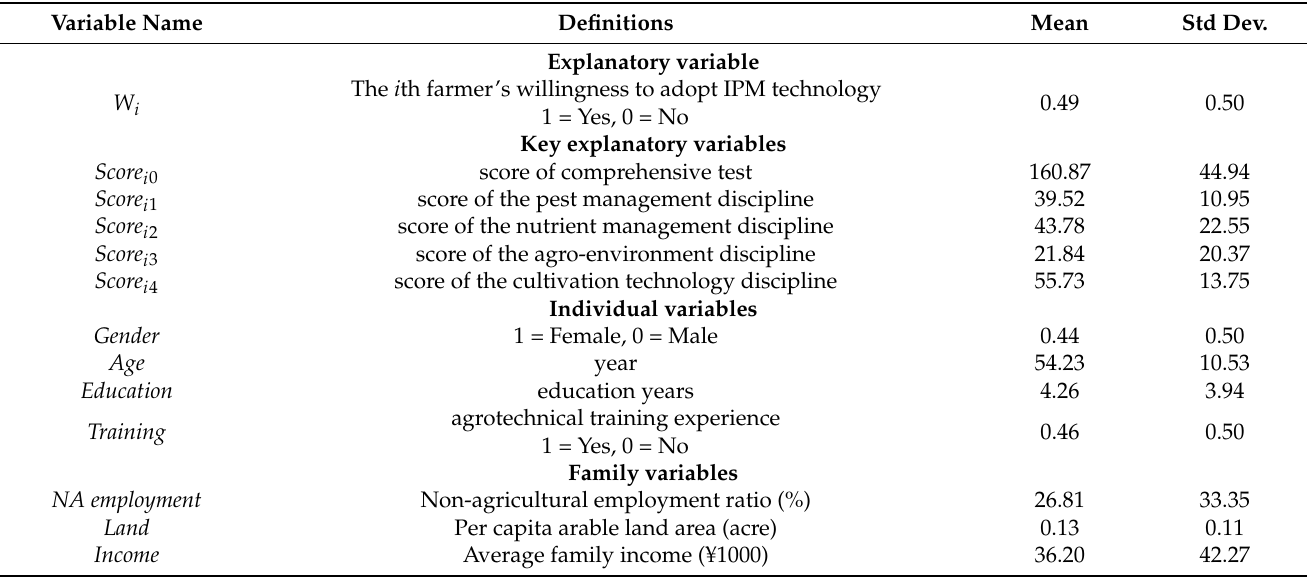
Table 2. Definitions and simple statistics of variables (mean